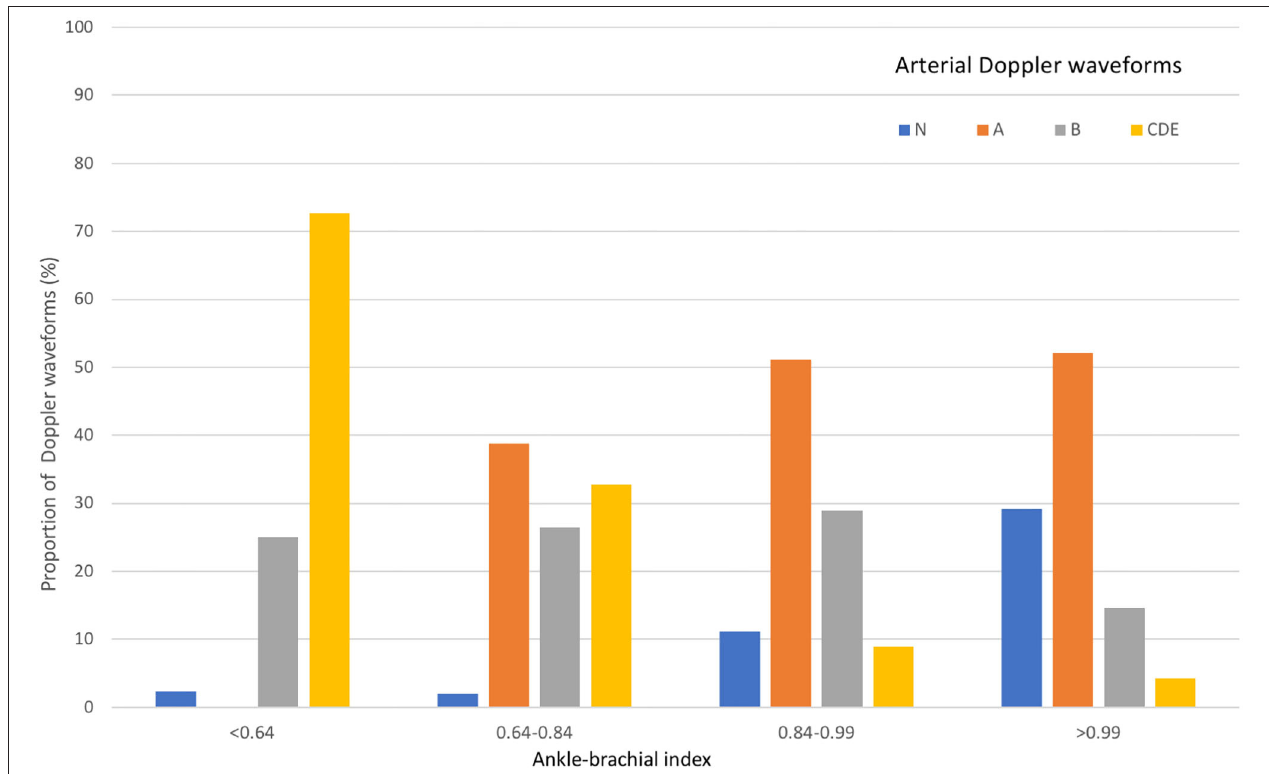
FIGURE 4 | Distribution of best arterial Doppler waveforms based on ankle-brachial index.